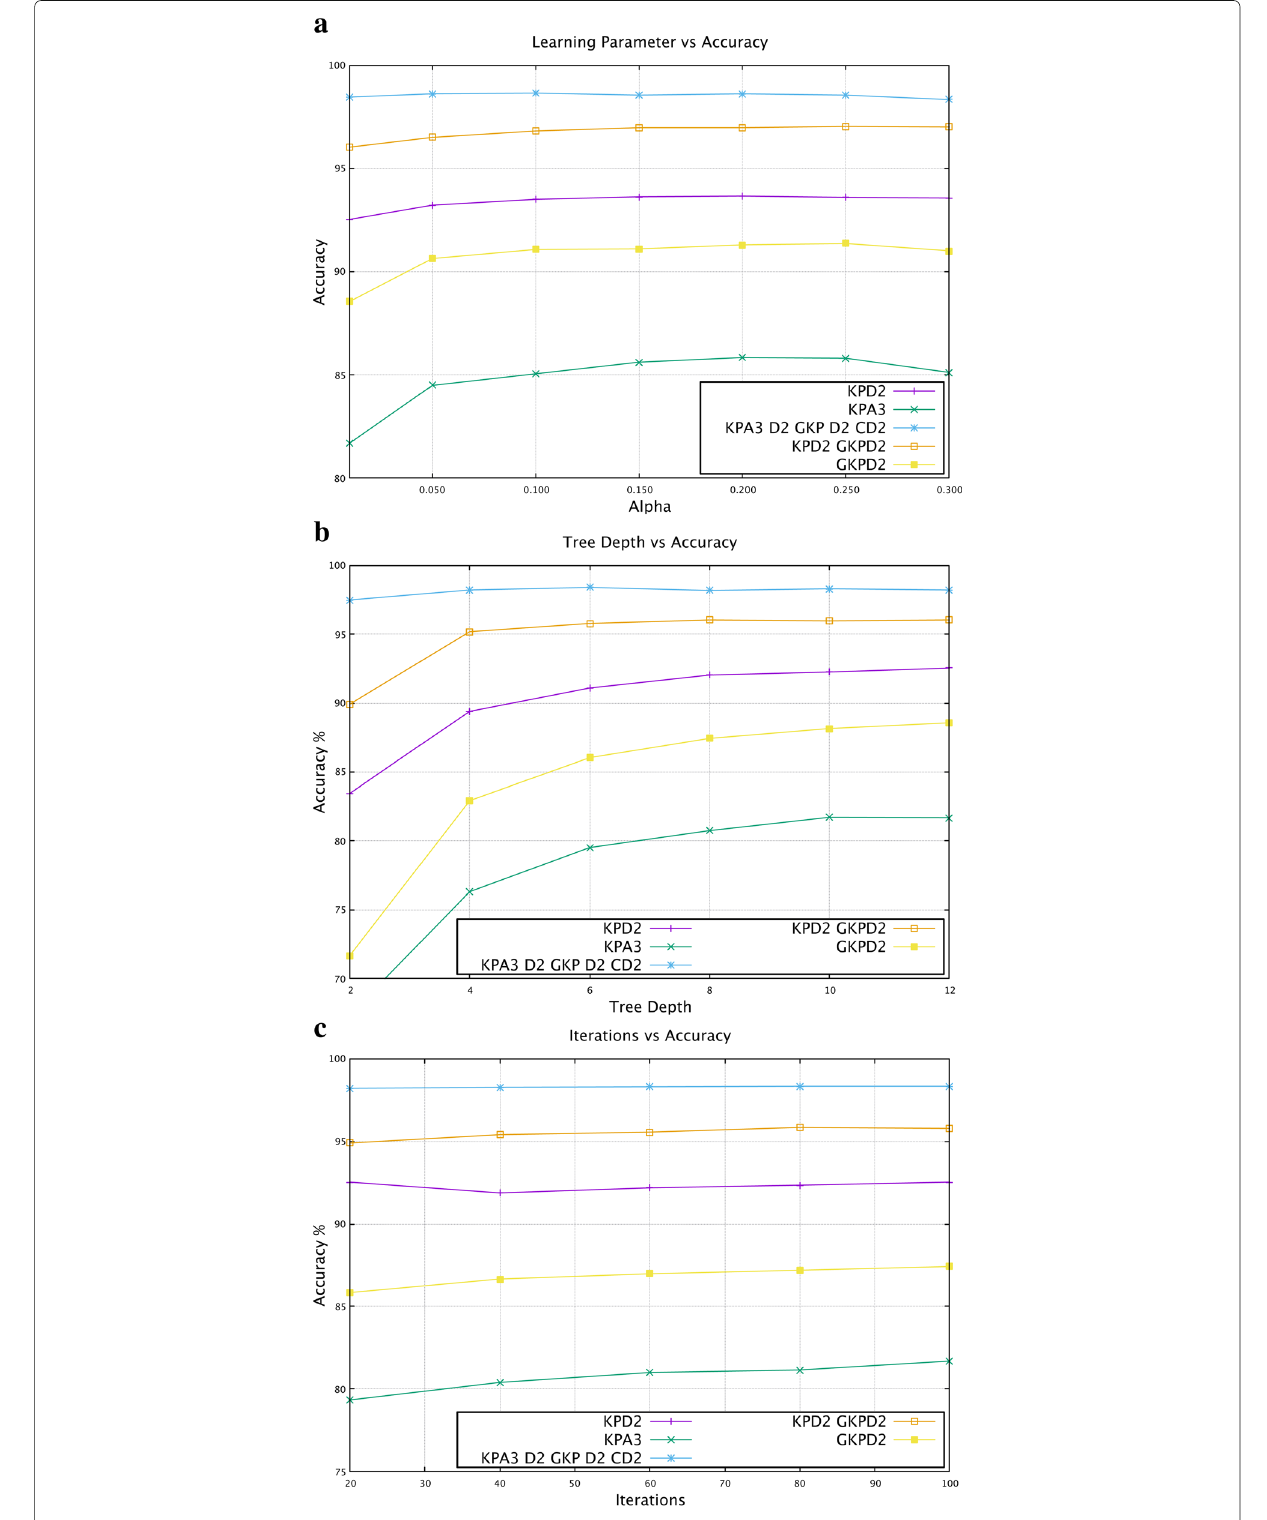
Fig. 21 a Learning rate with accuracy of model. b Max tree depth with accuracy. c Booster round iterations with